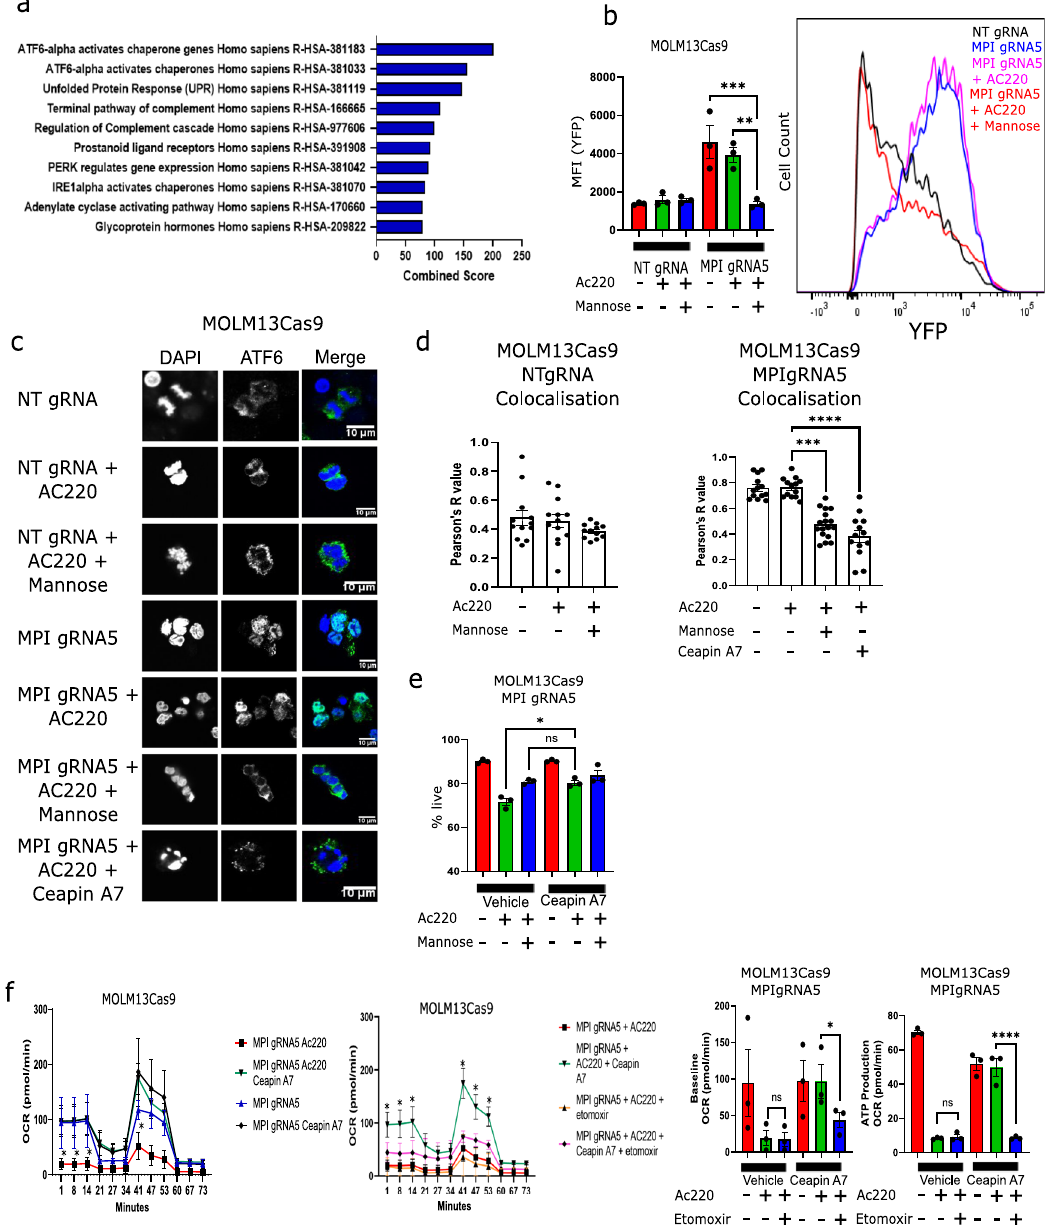
Fig. 5 | MPI KO cells activate the ATF6 arm of the unfolded protein response (UPR) to inhibit oxidative phosphorylation metabolism in AML cells. a Top combined score gene signatures from RNA sequencing enriched in MPI gRNA5 MOLM13 cells compared to NT gRNA MOLM13 cells. Analysis performed with Enrichr; b Mean fl uorescence intensity of YFP from MOLM13 NT gRNA or MPI gRNA5 cells expressing a YFP linked ATF6 reporter treated with vehicle, AC220 (1nM), mannose (100 µ M) or combinations as indicated (left panel) with a repre- sentative fl ow cytometry plot (left right panel). N =3, 1 way Anova with Tukey ’ s correction for multiple comparisons; ( c ) Confocal microscopy images of NT gRNA andMPIgRNA5MOLM13cellsstainedforDAPI(blue,1stcolumn)andATF6(green, 2nd column) with a merged image (3rd column), treated with vehicle, AC220 (1nM), mannose (100 µ M), Ceapin A7 (1 µ M) or in combinations as indicated 72h after treatment. Experiment performed 3 times independently; ( d ) Colocalisation analysisfrom immuno fl uorescence images of NTgRNA (left)and MPIgRNA5(right) MOLM13cellstreatedwithvehicle,AC220(1nM),mannose(100 µ M)andCeapinA7 (1 µ M) in combinations as indicated. Analysis performed with Coloc2 plugin in